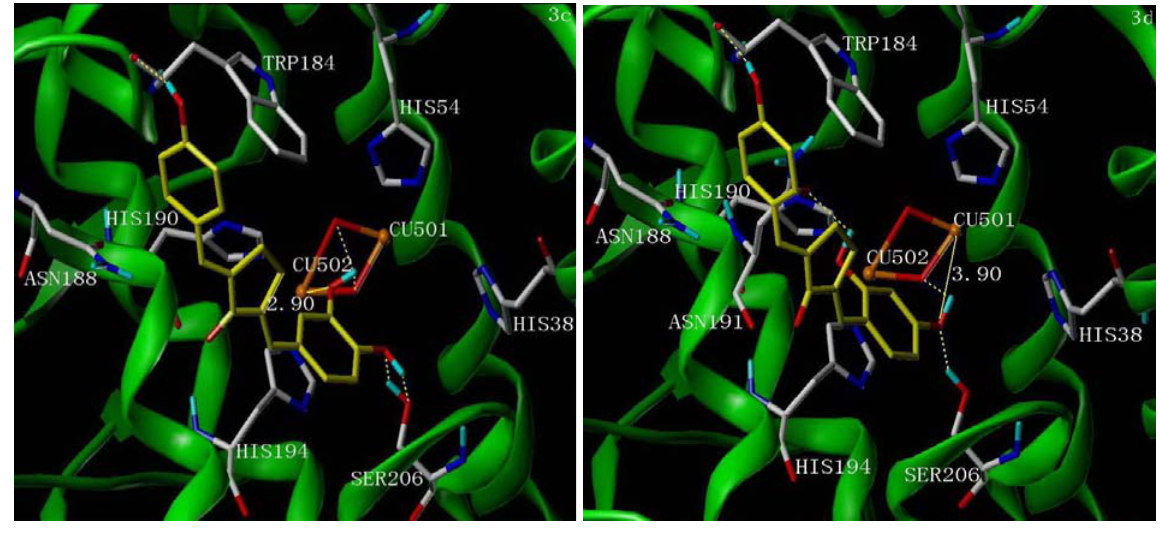
Figure 3. The proposed binding modes of 3c (left picture) and 3d (right picture) in the active site of tyrosinase (PDB access code 2ZWE). The inhibitor molecules are colored in yellow for carbon atoms. The dashed lines show hydrogen-bonding, the real lines show the distance of metal-coordination interactions. The docking models are generated using